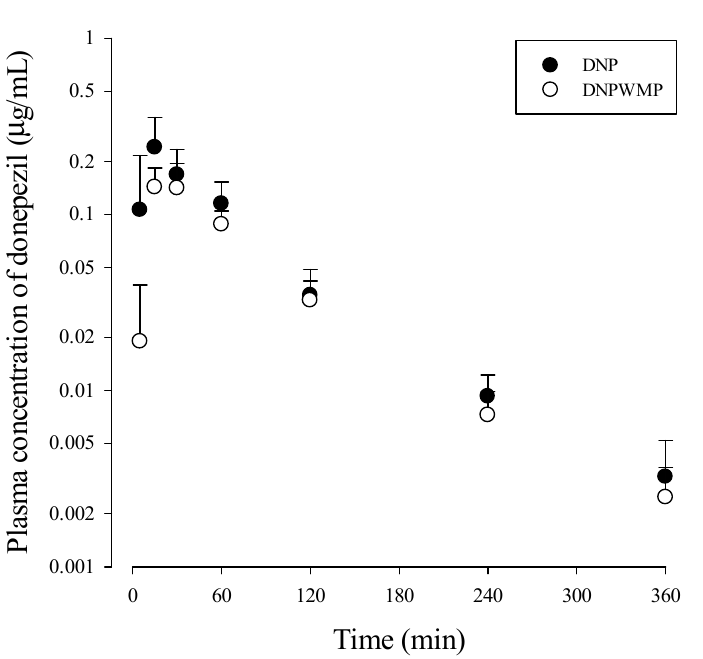
Figure 2. Plasma concentration-time curve of donepezil after simultaneously oral administration of DNP (as 10 mg/kg of donepezil; n = 10 from 30 mice) with and without WMP (300 mg/kg; n = 10 from 28 mice) to mice. Three or four blood samples were obtained from each mouse by cardiac puncture, which produced ten sets of PK data. Each value represents the mean ±